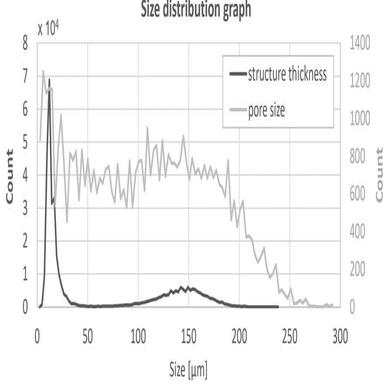
Size distribution graph of sample 4 showing the structural thickness and pore sizes based on the sphere-fitting algorithm.